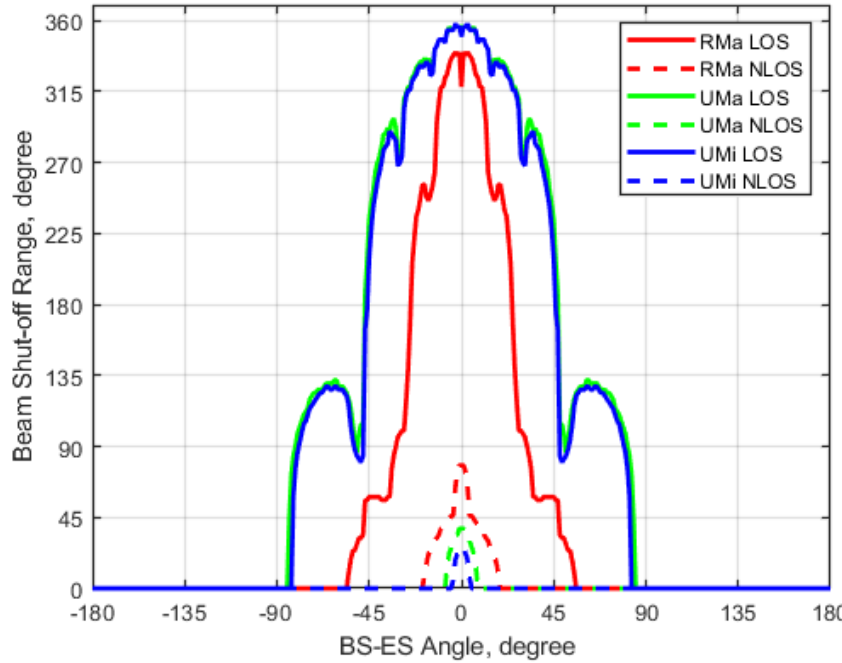
Figure 9. Beam shut-off angle vs. BS-ES angle (ES antenna elevation angle = −180° to 180°, d = 15 km, 4 × 4 antenna array).